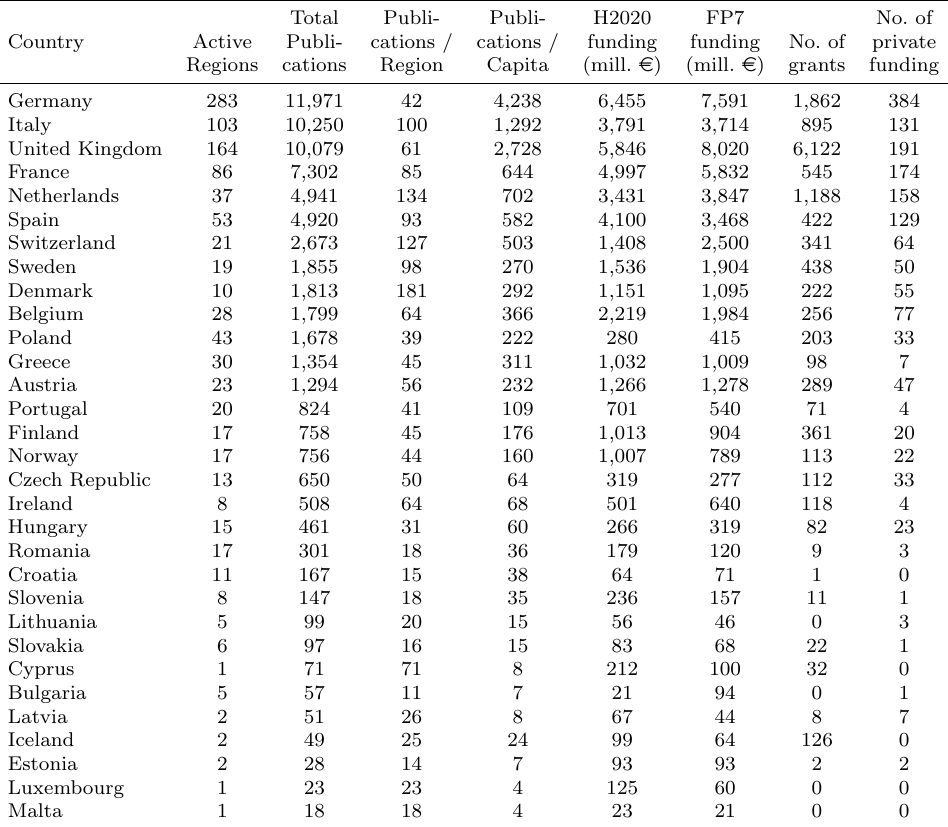
Table 2: Inputs and Outputs of the Knowledge Production Function of Cardiovascular Device Research by country, Europe